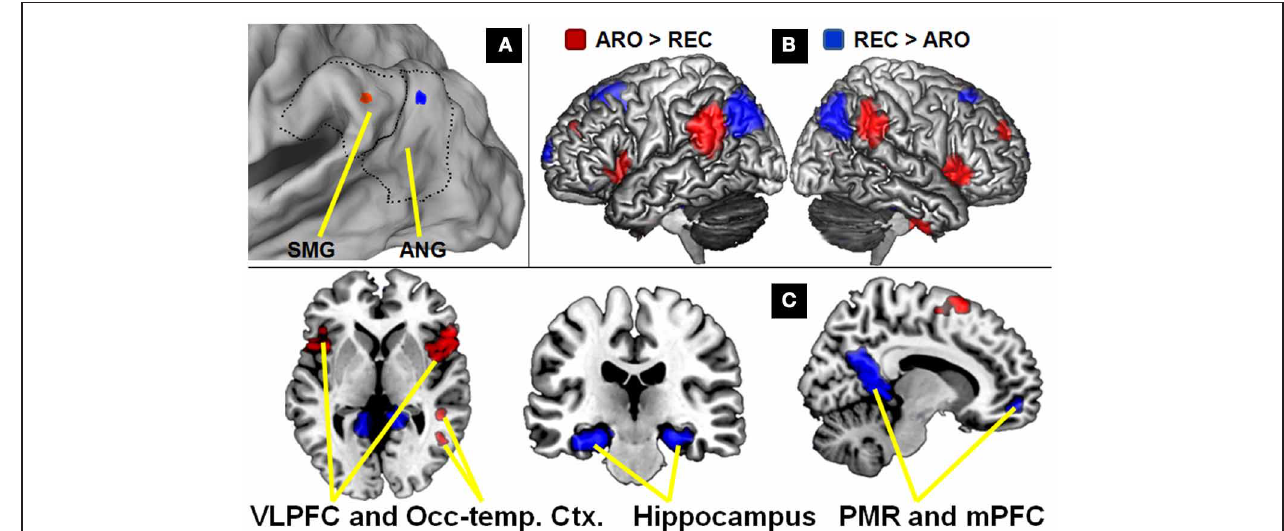
FIGURE 1 | Differences in connectivity between attention-reorienting and recollection seeds. (A) VPC coordinates derived from meta-analyses of attention-reorienting and recollection plotted on a 3D rendering. Dotted lines indicate the boundaries of VPC, and the solid black line in the middle the distinction between supramarginal gyrus (SMG) and angular gyrus (AG). (B) Comparison of the two seeds plotted on 3D renderings of the left and right sides of the brain, illustrating the hemispheric symmetry of the findings. Although left-sided seeds were used, results are